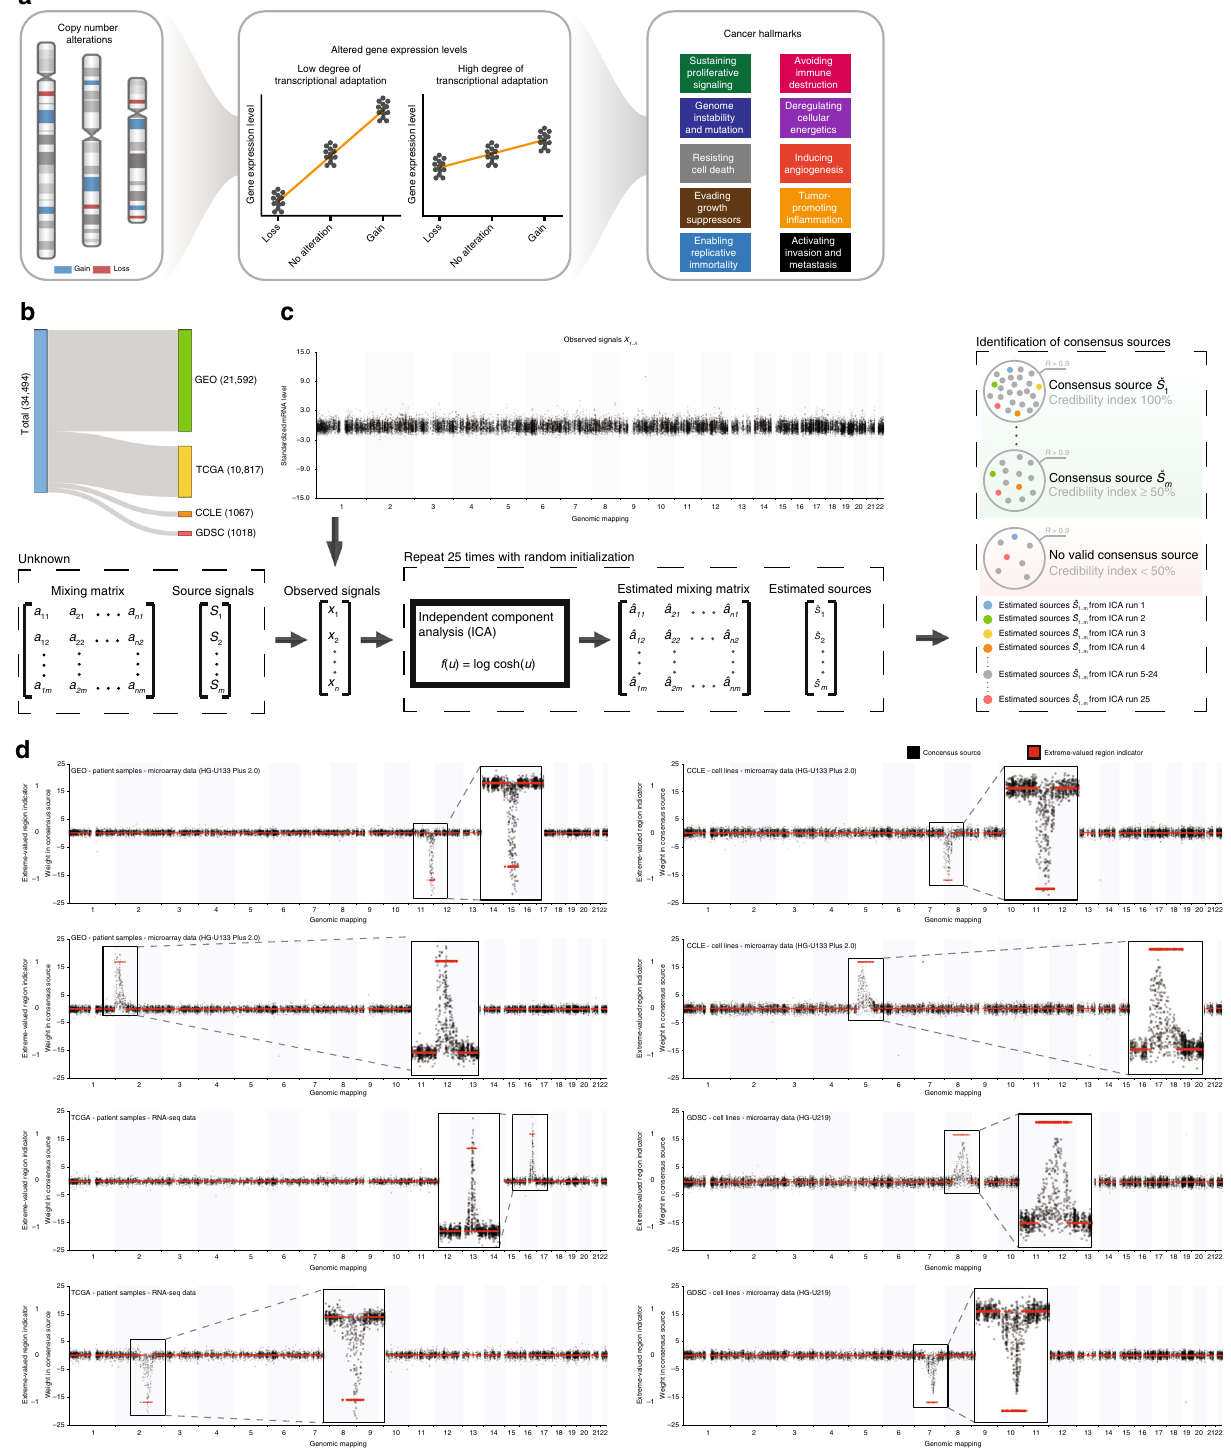
R > 0.9 Consensus source Š 1